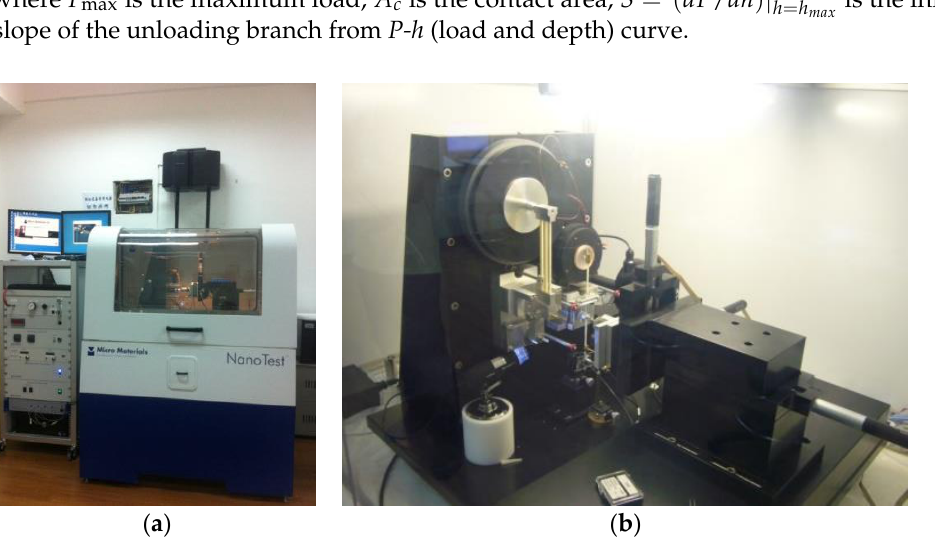
Figure 1. Samples for testing in nanoindenter [15,16]: ( a ) specimen 1; ( b ) specimen 2; and ( c ) speci- mens installed.